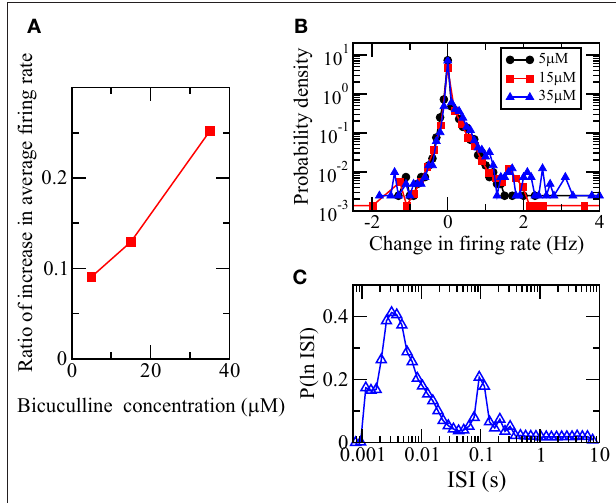
FIGURE 7 | Heterogeneous responses of spiking activity of neuronal culture at 66 DIV to the addition of bicuculline. (A) Dependence of the ratio of the increase of the average firing rate of all 4,095 MEA channels for 66 DIV on the concentration of bicuculline. (B) Distributions of the change in firing rate of all the channels for the three different concentrations. (C) Distribution of logarithm of ISI, P(ln ISI), calculated using the spikes detected from the MEA recording